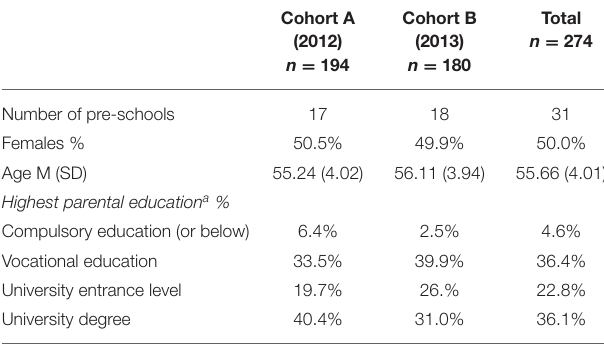
TABLE 1 | Participant